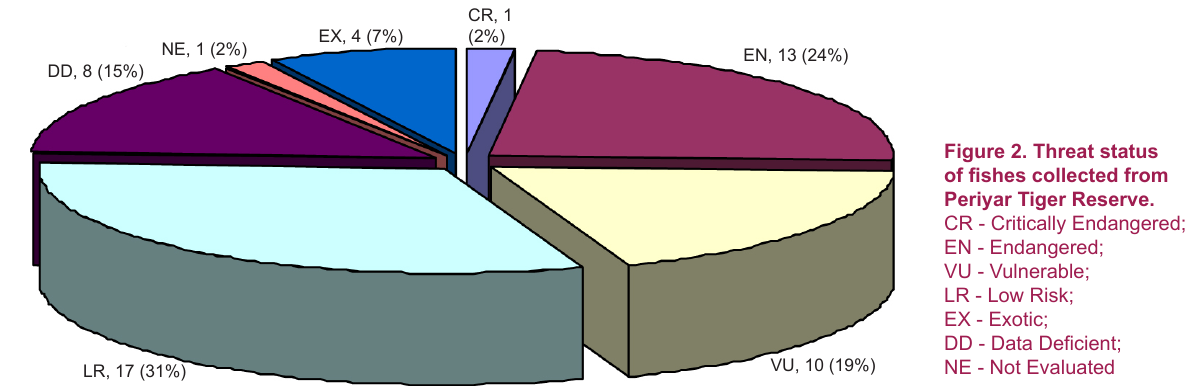
Figure 2. Threat status of fishes collected from Periyar Tiger Reserve. CR - Critically Endangered; EN - Endangered; VU -